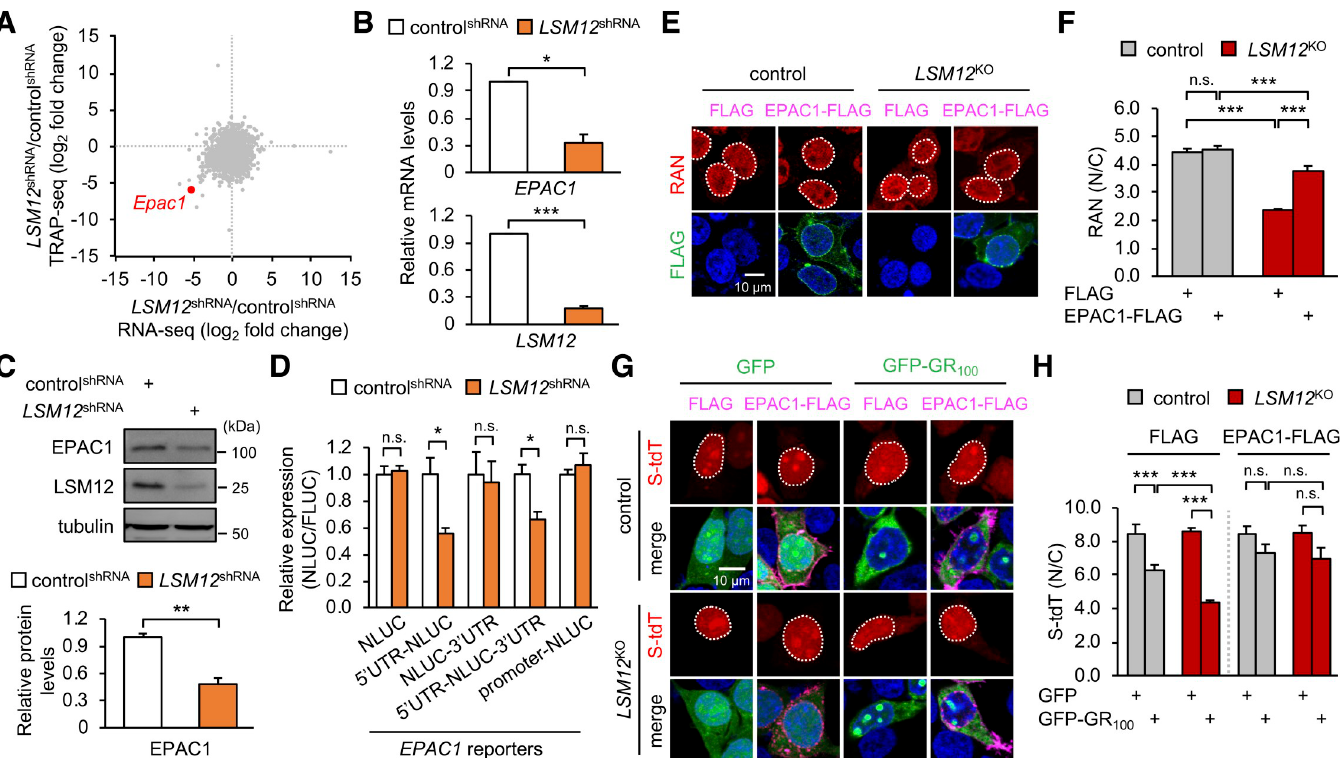
Fig 5. LSM12 posttranscriptionally up-regulates EPAC1 expression to sustain the RAN gradient for NCT. (A) Fold changes in total transcript levels (x-axis) versus translating ribosome-associated transcript levels (y-axis) in LSM12-depleted cells were assessed by RNA sequencing ( n = 2 biological replicates; n = 10,856 transcripts) and depicted as a scatter plot. (B) LSM12-depleted cells express low levels of EPAC1 transcript. Total RNA was prepared from control shRNA and LSM12 shRNA cells. The abundance of each transcript was quantified by real-time RT-PCR and normalized to that of GAPDH . Relative mRNA levels in LSM12 shRNA cells were then calculated by normalizing to those in control shRNA cells. Data represent means ± SEM ( n = 3). � P < 0.05, ��� P < 0.001, as determined by Student t test. (C) LSM12 - depleted cells express low levels of EPAC1 protein. The abundance of each protein was quantified as in Fig 1C. Data represent means ± SEM ( n = 3). �� P < 0.01, as determined